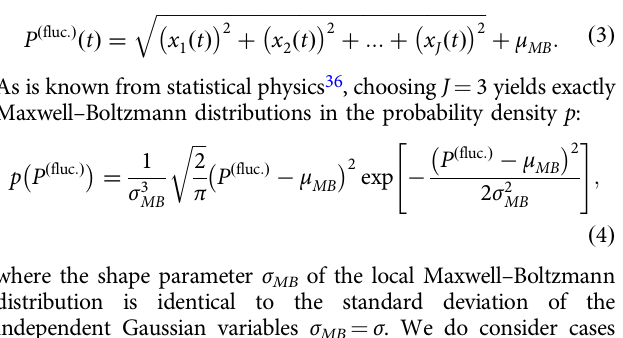
Fig. 5 Local Maxwell – Boltzmann distributions of power demand fl uctuations. a Using only the high-frequency modes from the empirical mode decomposition (EMD), we plot the consumption fl uctuations P ( fl uct.) over time. b , c Using superstatistical methods 32, 33 , we fi nd a long-time scale T ≈ 2000s, see also Supplementary Note 4. On this local time scale T , we observe local Maxwell – Boltzmann distributions, which can be very narrow ( b ) or broad ( c ). The histograms contain only 1000 (length of T , given a 2 s resolution) data points of P ( fl uct.) as local snapshots and we plot MB fi ts as references. In addition to the PDF, we compare the cumulative probability functions (CDF) of MB distribution with the data in the inset. All plots use the NOVAREF data from a test set in April. The time period and day are chosen for illustration purposes fl uctuations P ( fl uc.) are obtained by aggregating these Gaussian distributions and applying the observed shift from zero μ MB :